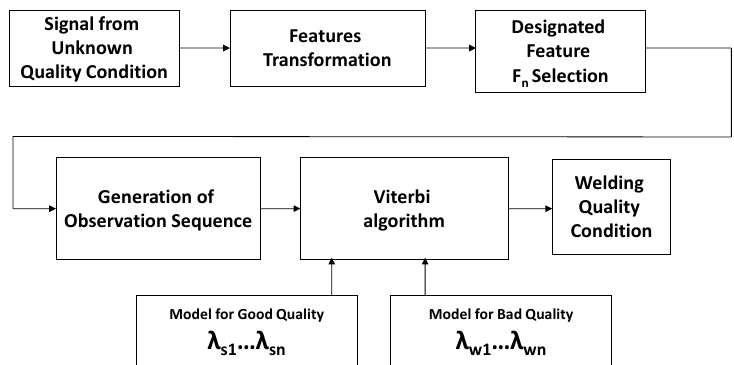
Figure 3. Schematic of determining unknown quality condition by using developed model [17].